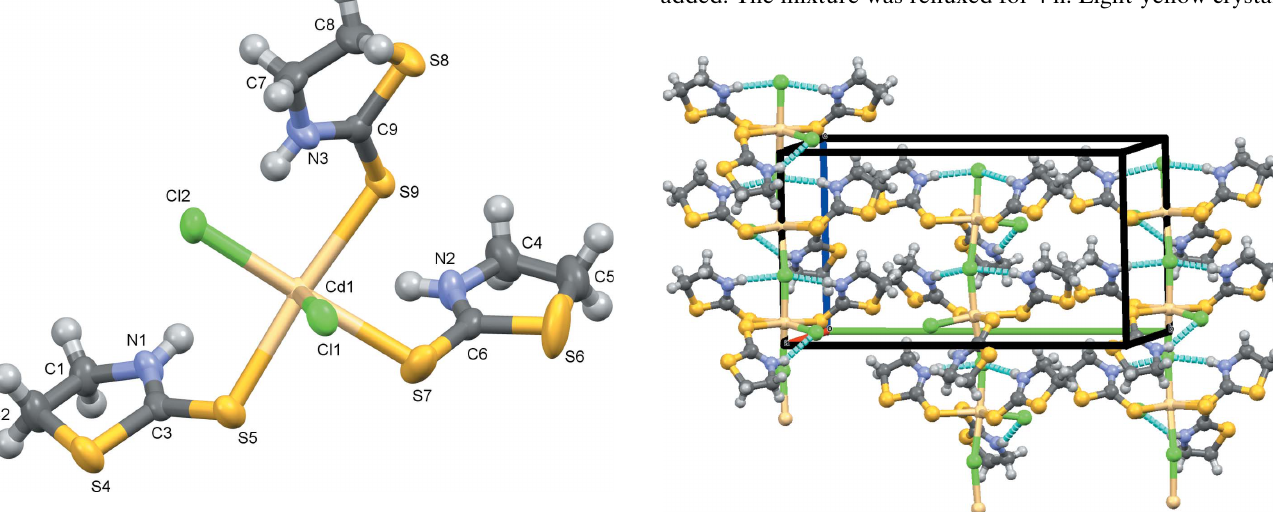
Figure 2 Packing diagram of the title compound. N—H (cid:2)(cid:2)(cid:2) Cl hydrogen bonds are show as light blue dashed lines.